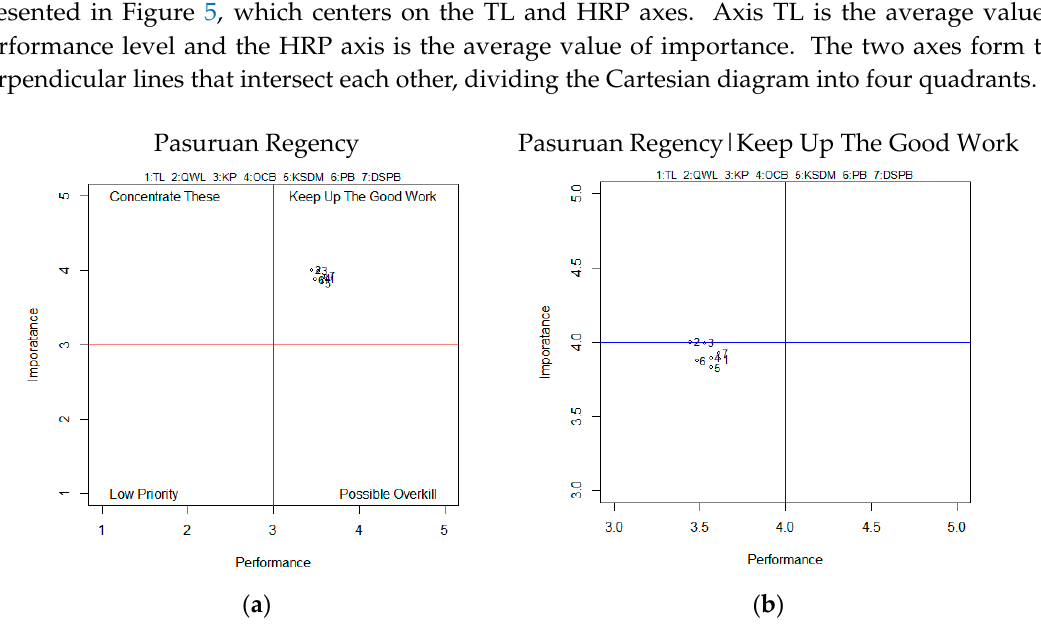
Figure 6. ( a ) IPA Cartesian Diagram of Sidoarjo Regency. ( b ) IPA Cartesian Diagram of Keep up the Good Work Quadrant of Sidoarjo Regency.